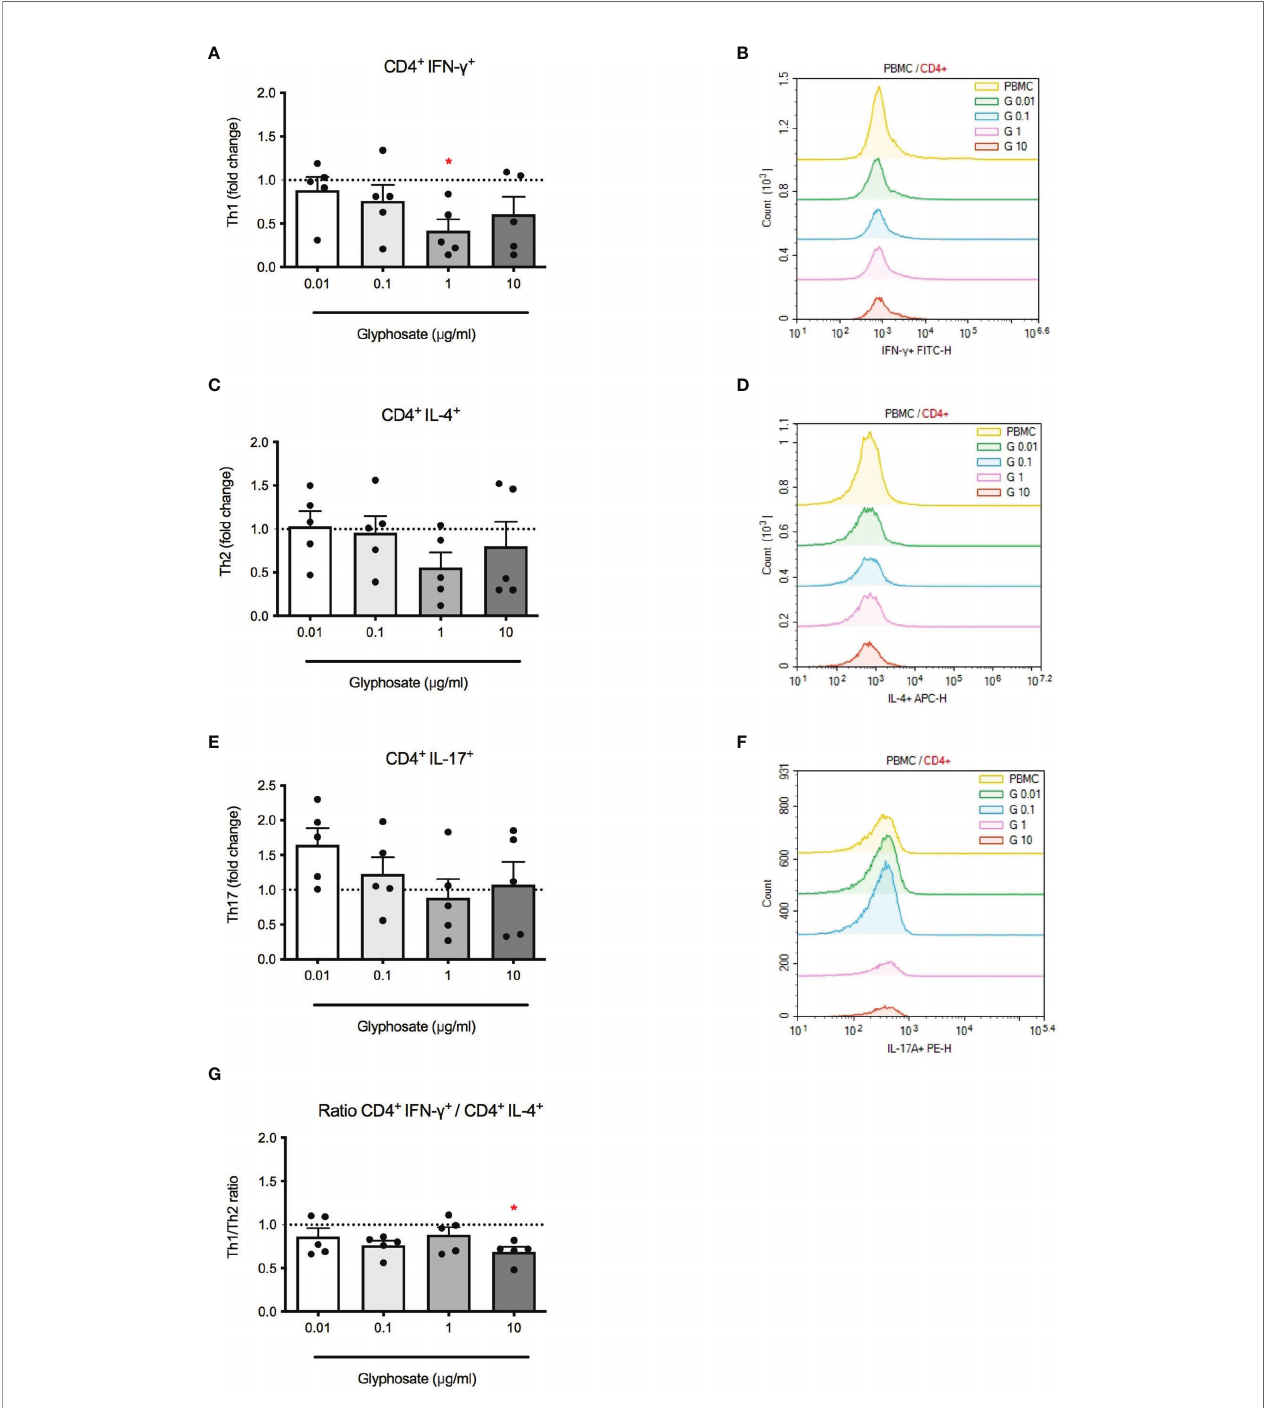
FIGURE 1 | Effect of G on PMA plus ionomycin-induced CD4 + cell differentiation. PBMC (10 6 /mL) were treated for 1 h with increasing concentrations of G (0.01, 0.1, 1 and 10 µg/mL), and then stimulated with PMA, ionomycin and GolgiStop ™ for 5 h, as described in the Materials and Methods section. (A) CD4 + IFN- g + cells. (C) + IL-4 + cells. (E) CD4 + IL-17A + cells. (G) CD4 + IFN- g + /CD4 + IL-4 + cell ratio. Results are expressed as fold-change of the number of positive cells in G treated cells compared to control cells. The dotted line reported is set at 1.0 (control). Each value represents the mean ± SEM, n = 5 donors. Each dot represents the value of the single individual. Statistical analysis was performed with Dunnett ’ s multiple comparison test, with * p < 0.05 vs control cells. Flow cytometric analysis of representative histogram overlay were reported in (B, D, F)